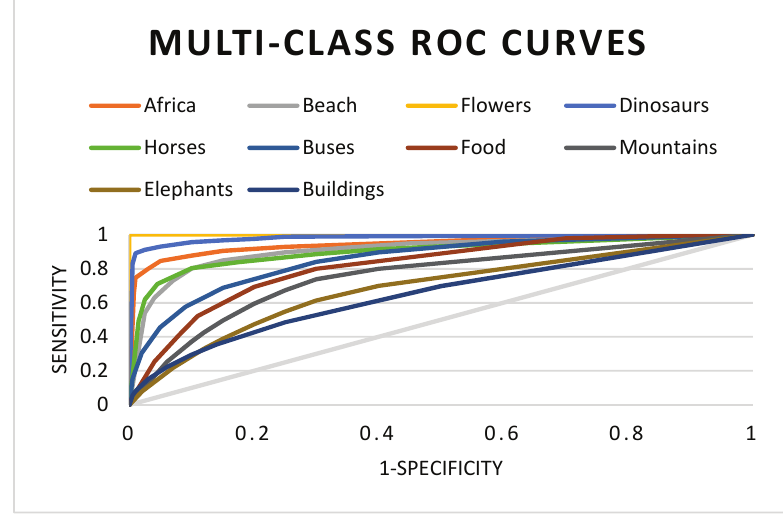
Figure 9. Comparison of average precision versus rate of returned